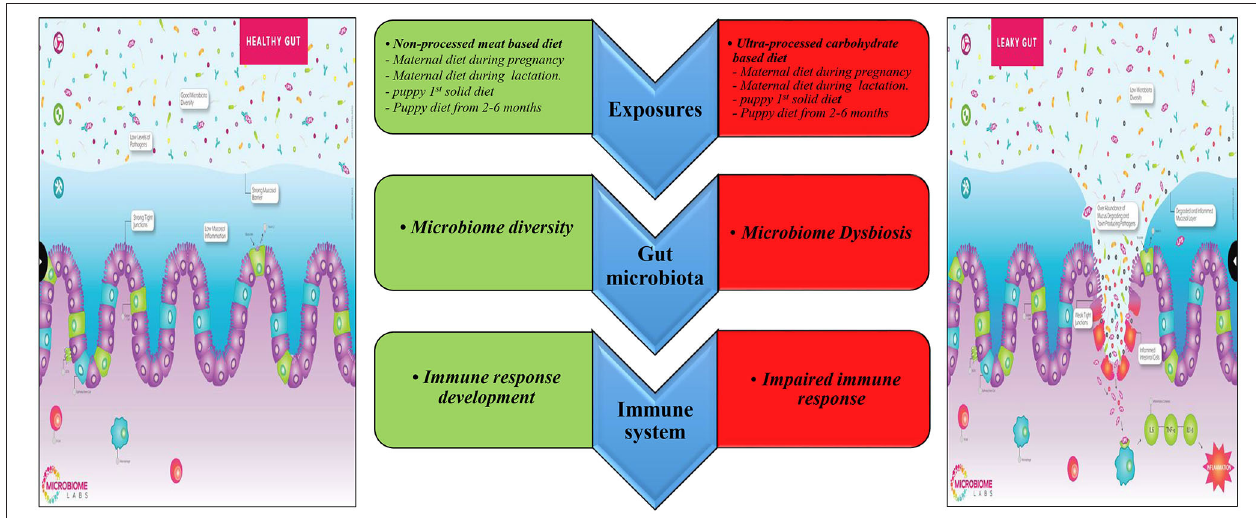
FIGURE 5 | Prospective mechanisms underlining the relationship between early diet and IBD in adult dogs. Edited from the Microbiome Labs (https://microbiomelabs.